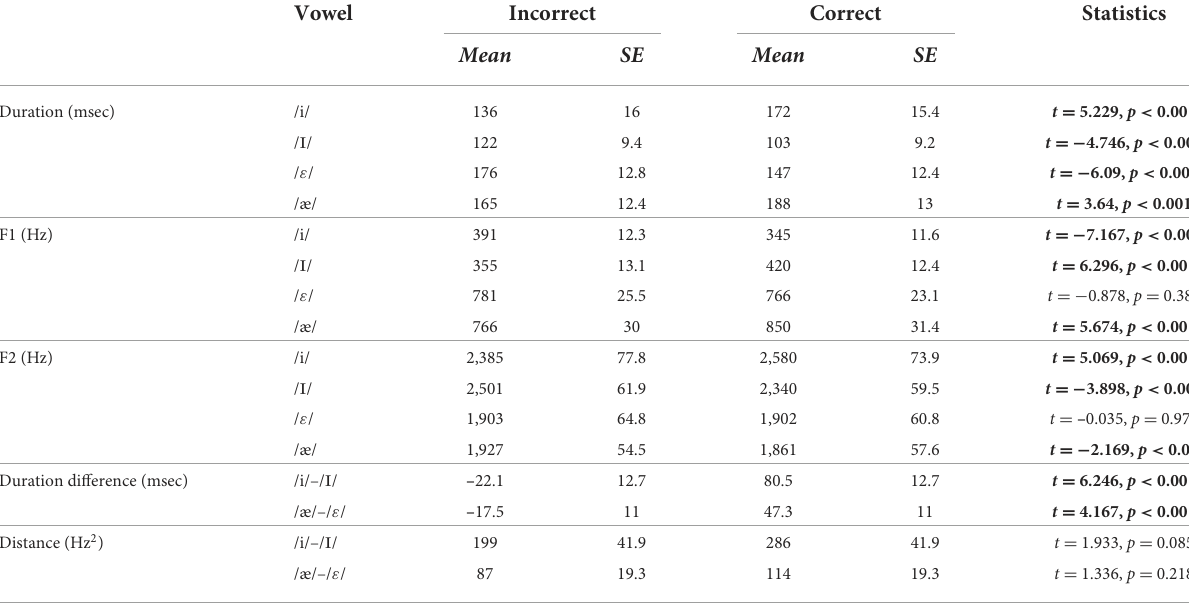
TABLE 2 Acoustic differences between vowels correctly and incorrectly recognized by Alexa (significant results are bolded).